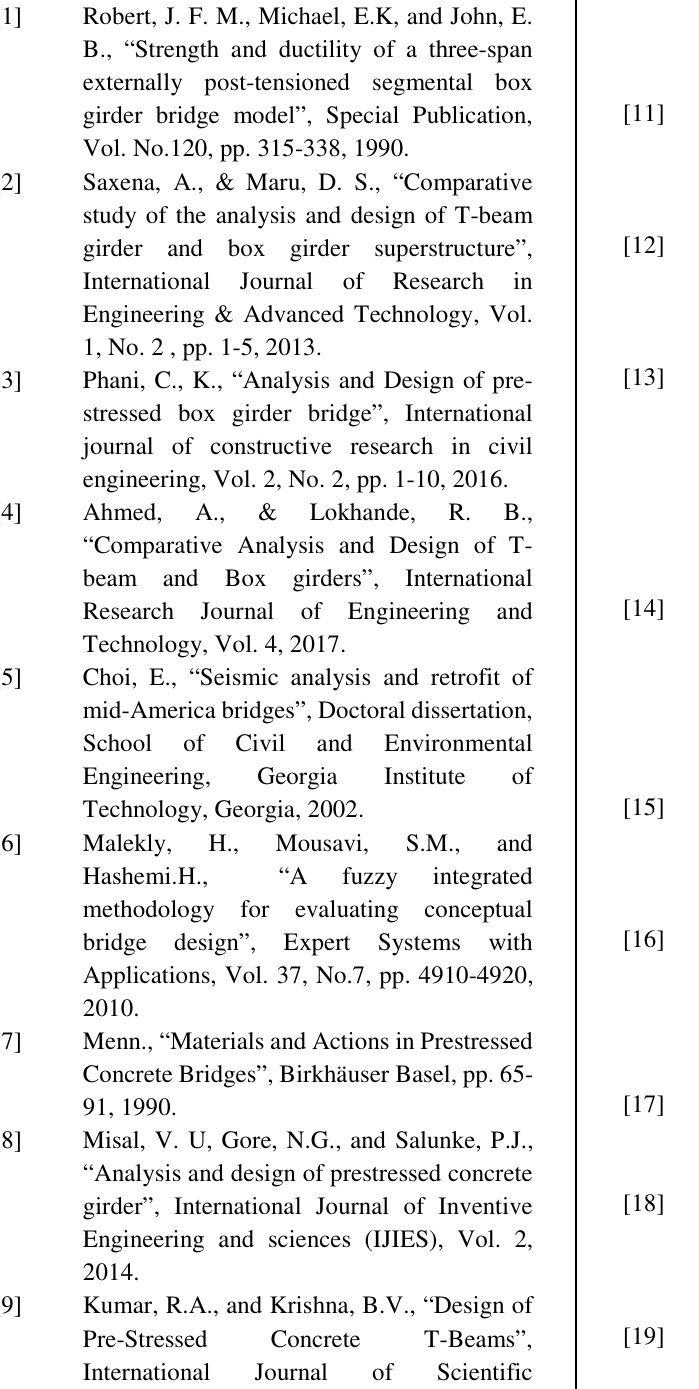
Bridge Design Specifications: Customary US